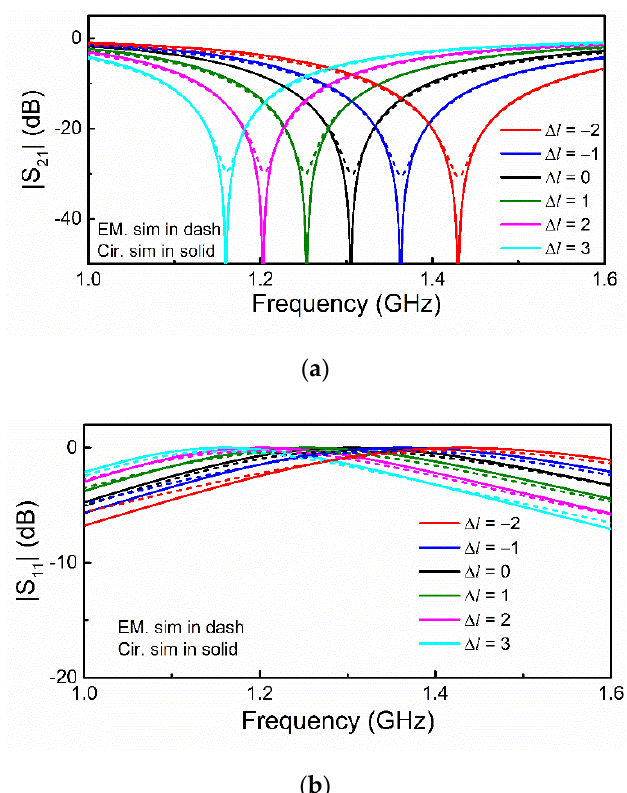
Figure 6. Responses (circuit and electromagnetic) of the DB-DGS-loaded microstrip line for various lengths of the narrow slot of the DB-DGS. ( a ) Magnitude of the transmission coefficient; ( b ) magnitude of the reflection coefficient. Minus sign in Δ l means reducing the length of the narrow slot. Table 1. Circuit parameters of the circuits of Figure 2 for different lengths of the narrow slot of the DB-DGS resonator .